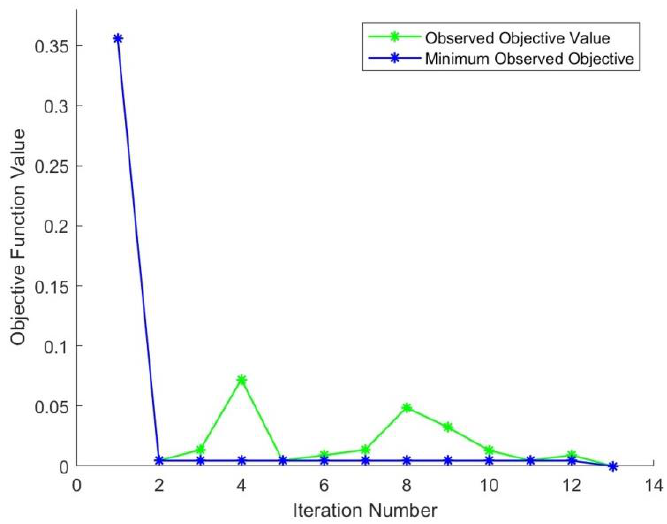
Figure 7. Objective function records versus the optimization iterations plot.